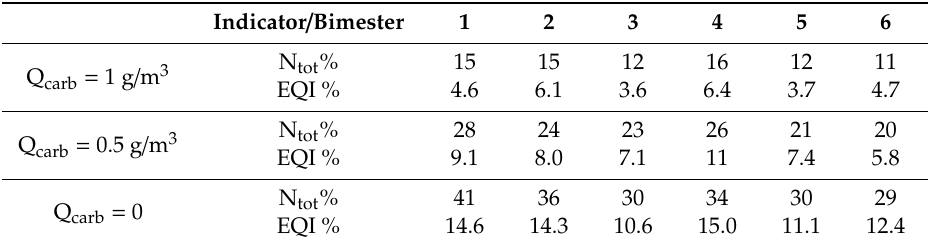
Table 11. Bimonthly variations on N tot and EQI with carbon dosage variations relative to default Q carb = 2 m 3 / d.